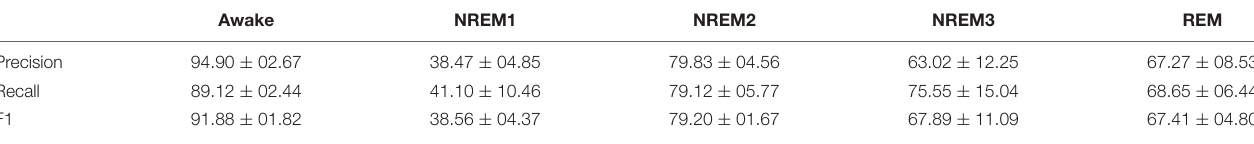
TABLE 2 | Model test